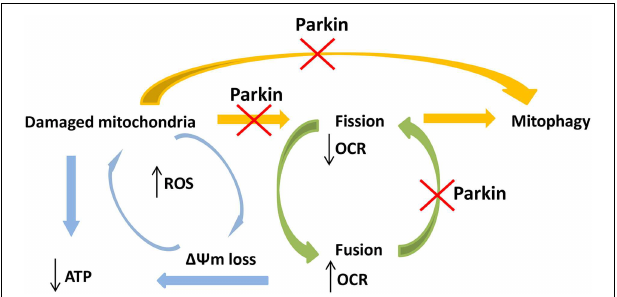
FIGURE 5 | Schematic view of the hypothetical connections between PARK2 mutations and impairment of mitochondrial functions. PARK2 mutations impair Parkin functionality and linked pathways, like mitophagy and fission process. Dysfunction in Parkin may interfere in both these pathways implying an accumulation of damaged mitochondria, with ATP loss. Mutations in PARK2 may also compromise the physiological mitochondrial fission process. This implies that mitochondria are forced to stay in a fuse state, with high respiration rate and impaired membrane potential ( 19 m), causing ROS increase and subsequently damage to mitochondria. These events create a vicious circle where not only the physiological damaged mitochondria were not removed but, in absence of Parkin, also newly synthesized mitochondria are more likely prone to accumulate